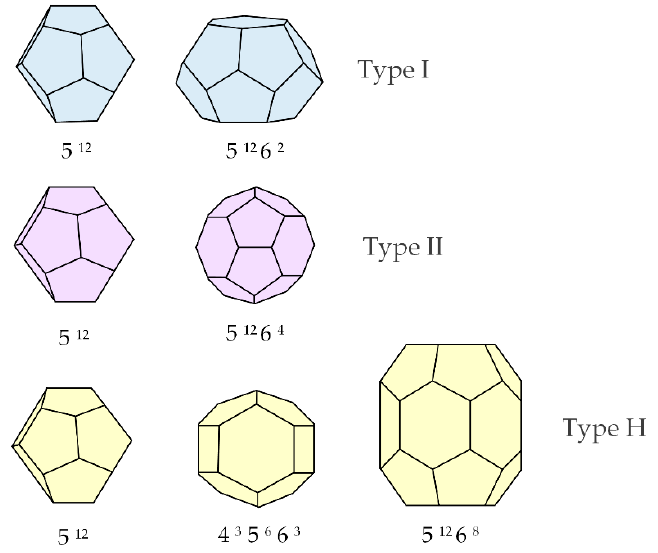
Figure 1. Different cages of gas hydrates (N m , where N—number of angles in a polyhedron and m—number of polyhedron faces).